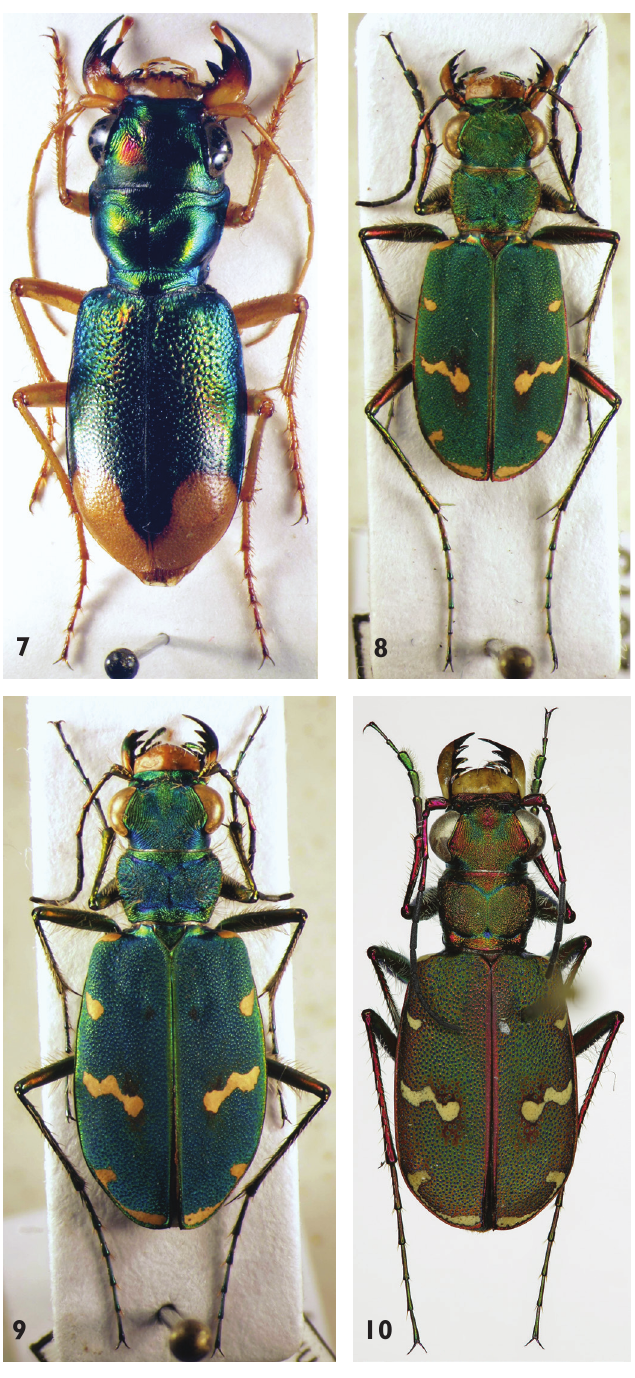
7 8 Figures 7–10. Cicindelidae species: 7 Grammognatha euphratica (female) 8 Cicindela javetii (male) 9 C. javetii (female) 10 C. javetii (male, paratype of thughurica ).